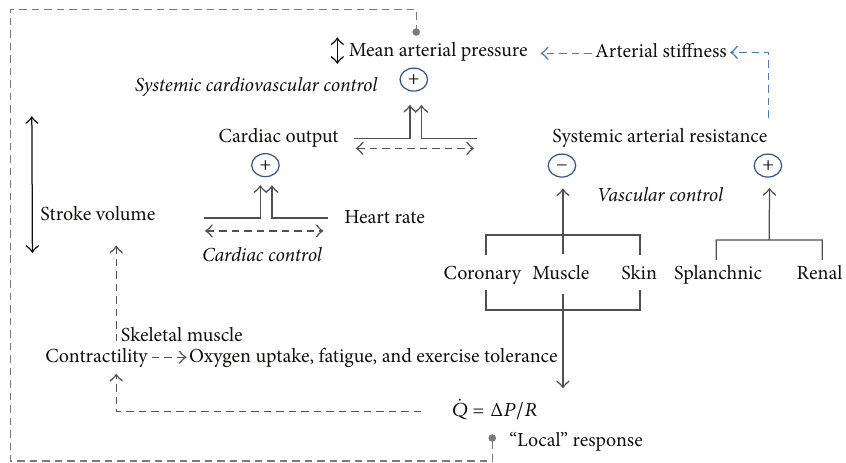
Figure 1: A simple conceptual model of cardiovascular control during exercise with links to oxygen uptake, fatigue, and exercise tolerance. Definitions of terms and description of most interrelationships between variables are described in the main text. The length of bidirectional arrows indicates the relative ranges of variables: the regulated variable, mean arterial pressure, varies through a smaller range than controlled variables such as cardiac output and systemic arterial resistance. Dashed bidirectional arrows indicate interactions between two variables. Arterial stiffness is not considered to be a part of a system of cardiovascular regulation and control, but it is influenced by this system (systemic arterial resistance) and also exerts an independent influence on mean arterial